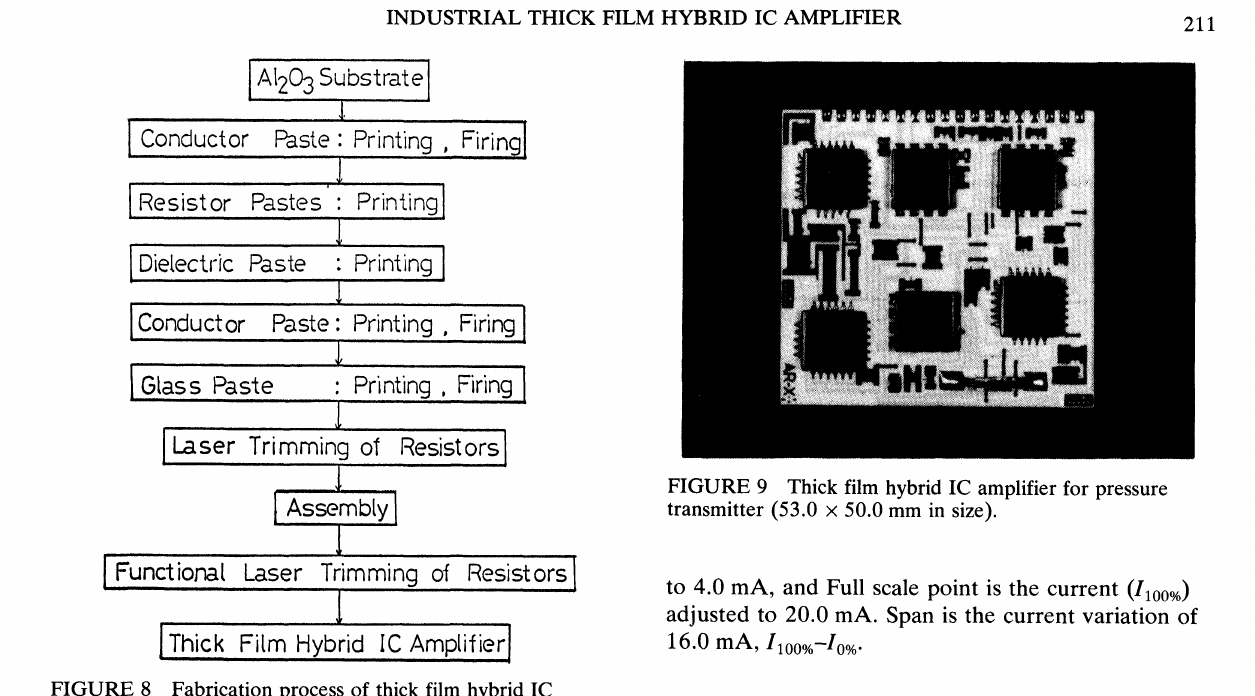
FIGURE 8 Fabrication process of thick film hybrid IC amplifier for pressure transmitter.